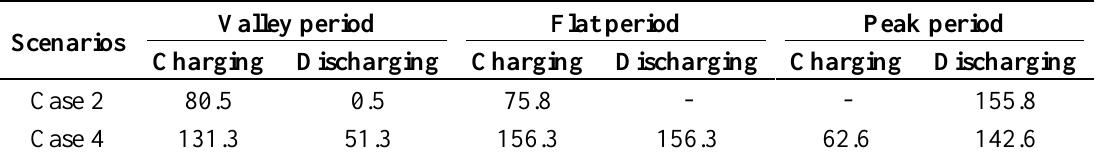
Table 5. Charging and discharging optimization results of energy storage system (MW·h).